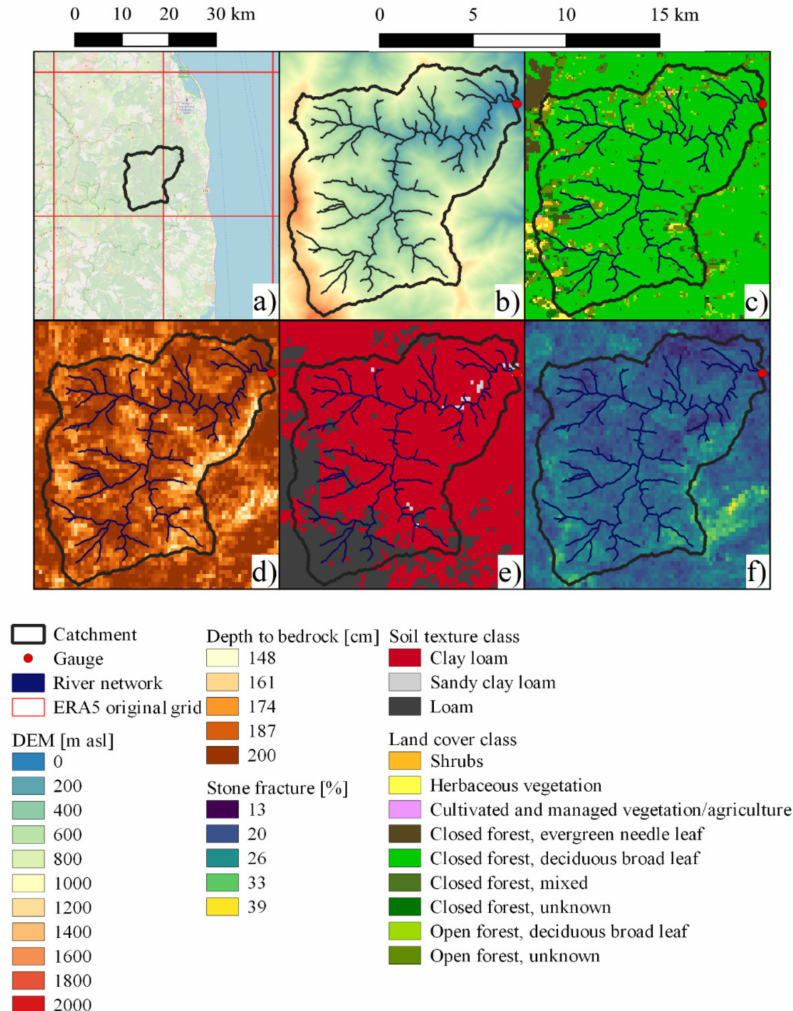
Figure 2. Outlook on the input datasets (WGS-84 Pseudo-Mercator projection) for Alto river–Taglio– Isolaccio(42.44 ◦ N9.47 ◦ E,Corsica, France): ERA5[15]gridtileswithOpenStreetMapasbackground[66] ( a ); digital elevation model based on SRTM30 [65] ( b ); Global Land Cover [21] classes ( c ); SoilGrids250 [22]—depth to bedrock ( d ), soil texture classes (7th layer) ( e ), and soil coarse fragment fracture (7th layer) ( f